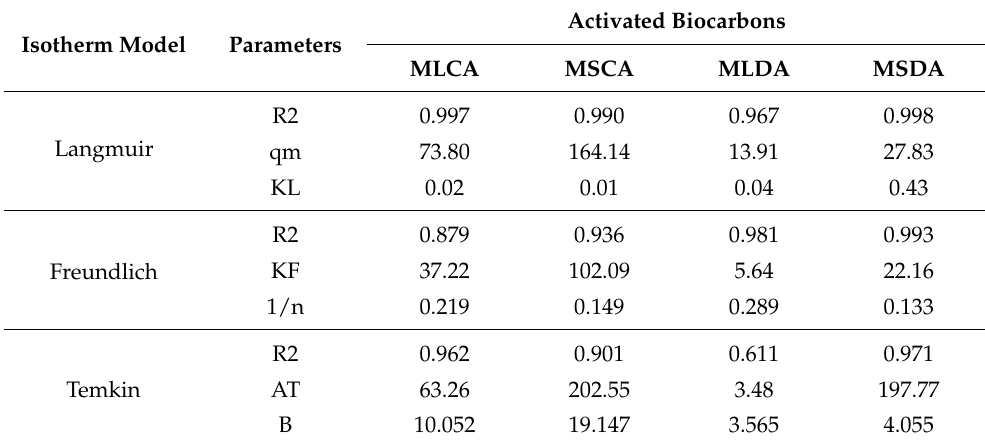
Table 5. Langmuir, Freundlich and Temkin parameters of the isotherms of methylene blue adsorption on the activated biocarbons prepared from mugwort post-extraction